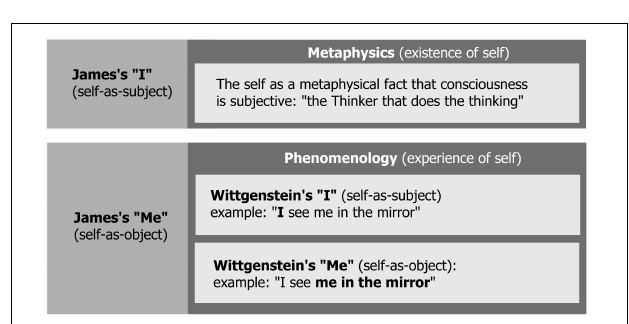
FIGURE 1 | An illustration of James (1890) and Wittgenstein’s (1958) distinctions between self-as-object (“Me”) and self-as-subject (“I”). In the original formulation, James’ (1890) “Me” includes also physical objects and people (material and social “Me”) – they were not included in the picture, because they are not directly related to